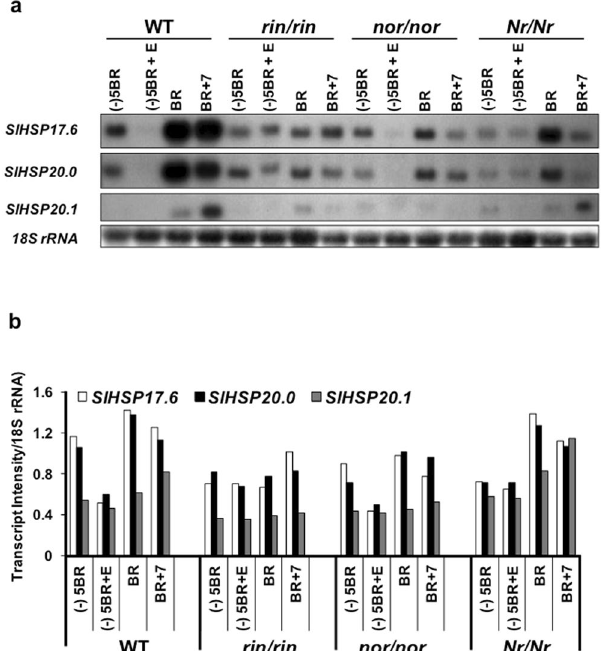
Figure 2. RNA blot-analysis of class-I SlHSP ( 17 . 6 , 20 . 0 and 20 . 1 ) genes in wild type ( Solanum lycopersicum cv. Ailsa Craig) and its ripening mutants. ( a ) Fruits from wild type tomato var. Ailsa Craig along with near isogenic lines of ripening-inhibitor ( rin / rin ), non-ripening ( nor / nor ) and Never-ripe ( Nr / Nr ) mutant fruits were harvested at mature green [5 days before breaker ( − )5BR)], breaker (BR) and red ripe (7 days after breaker, BR + 7) stages as described 25 . RNA was isolated, separated on gels, blotted and northern blot analysis carried out 25 , using gene specific probes as previously described 46 . Fruits at mature green stage ( − )5BR from the indicated lines were given ethylene treatment and designated as ( − )5BR + E. ( b ) Quantification of northern blot analysis using Image J program (https://imagej.nih.gov/ij/). The band intensity was calibrated with the band intensity of 18 S rRNA internal control used in northern